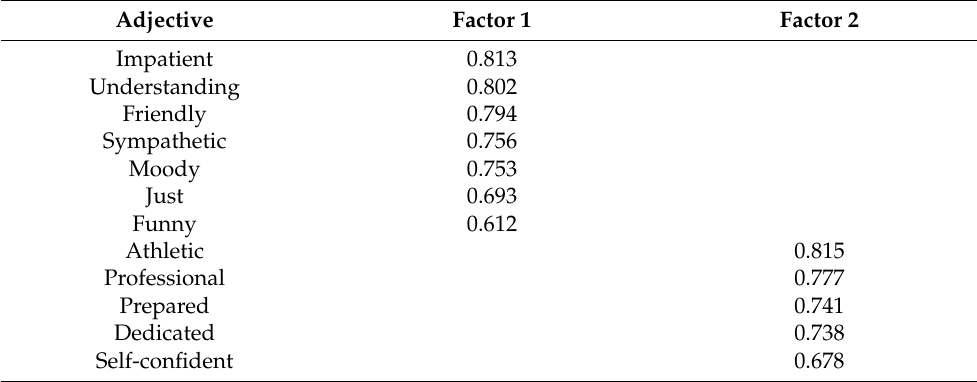
Table 2. Outcomes of the Exploratory Factorial Analysis on the pool of adjectives describing physical education teachers’ characteristics (Principal Components extraction method; Varimax rotation with Kaiser